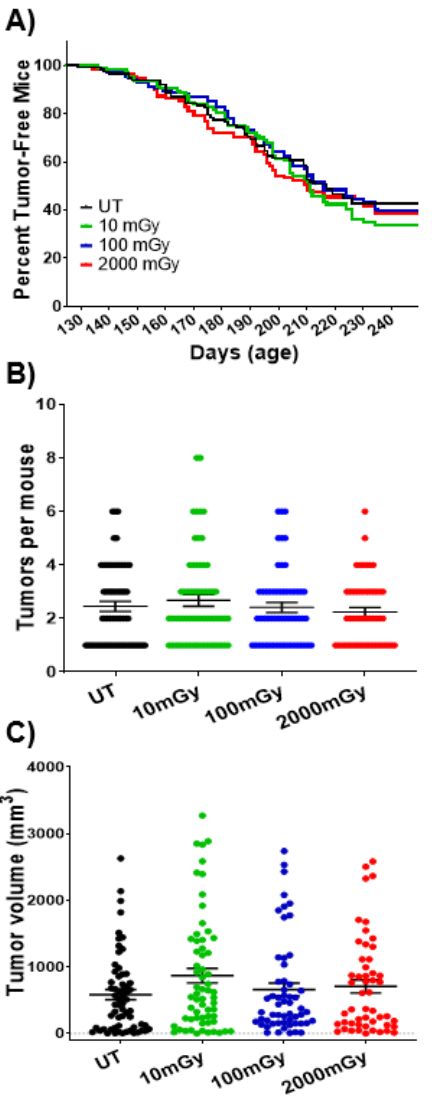
Figure 8. LDR has no impact on tumor development and burden. Transgenic “MMTV-Neu” female mice were exposed to total doses of 0, 10, 100, and 2000 mGy of chronic low-dose tritium. Exposures started at 1.5 months of age and were delivered via drinking water over 56 days. These transgenic mice develop their first spontaneous tumors at the age of 4 months. ( A ) Percentage of tumor-free mice was measured starting from the age of 130 days. ( B ) Number of tumors per mouse and ( C ) tumor volume were measured in tumor-bearing mice at the time of sacrifice. Data represent mean + SD.